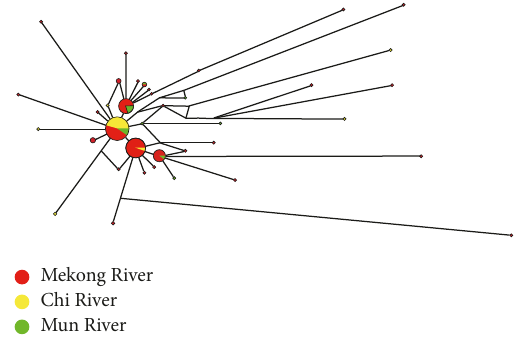
Figure 2: Median joining (MJ) network of 124 mitochondrial cytochrome b (cyt b) sequences of Belodontichthys truncatus . Each haplotype is represented by a circle and sizes of circles are relative to number of individuals sharing a specific haplotype. Haplotypes are labelled according to the river.